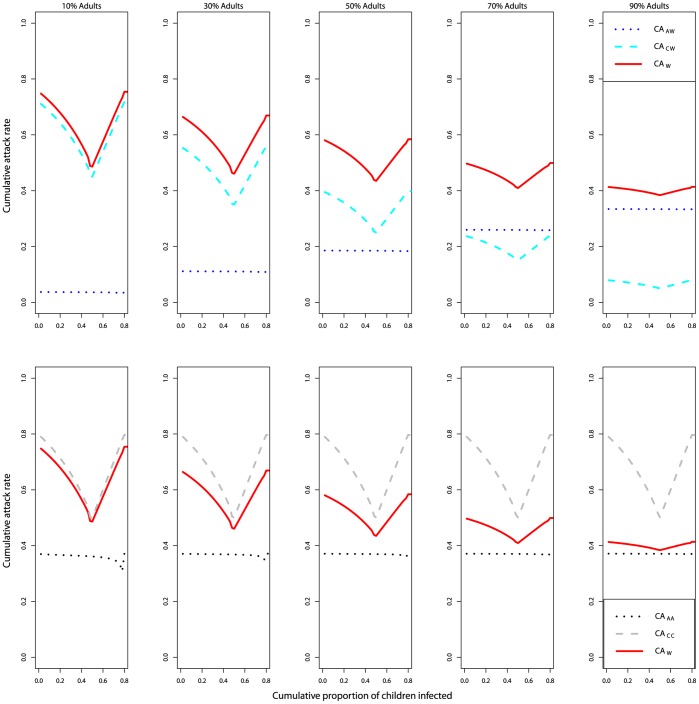
Cumulative attack rates (CA) against children’s population trigger (defined as the cumulative proportion of children infected), in the absence of inter-group transmission (βAC = βCA = 0).Everything else as described in Figure 4 legend. Note that the x-axis does not go beyond a threshold level of 0.8 since even an unmitigated outbreak does not reach a higher attack rate among the children and therefore an intervention would not be triggered.